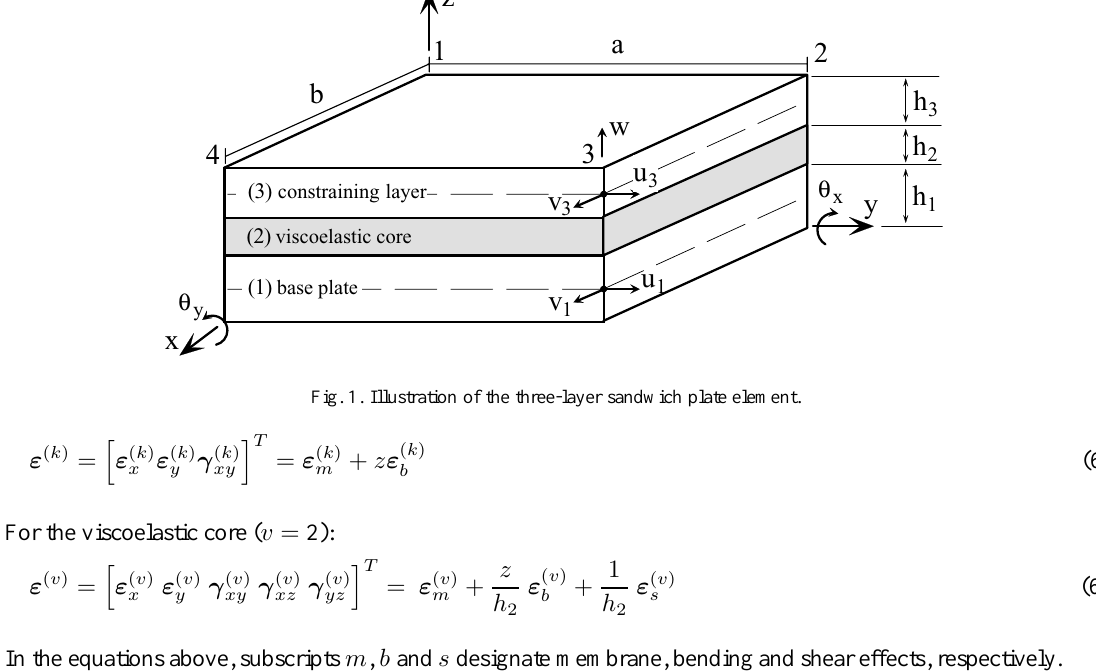
Fig. 1. Illustration of the three-layer sandwich plate